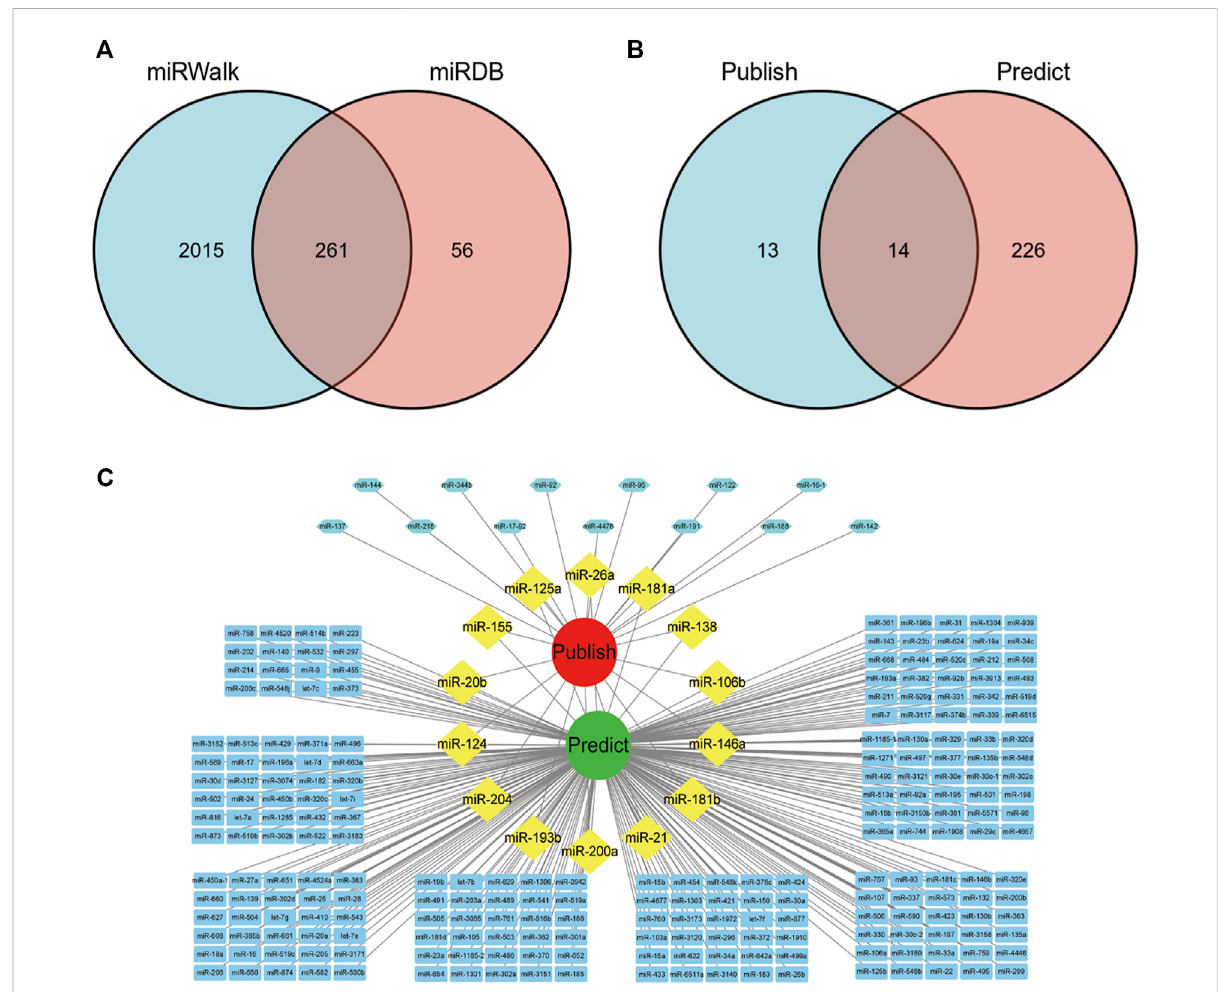
miRNAs acting on overlapping targets of SLE and TP. (A) Venn diagram of miRNAs predicted by the miRWalk and miRDB databases. (B) Venn diagramofTP-relatedmiRNAsveri fi edinliteratureandpredictedinthispaper. (C) VisualizationofthenetworkdiagramofTP-relatedmiRNAsveri fi ed in literature and predicted in this